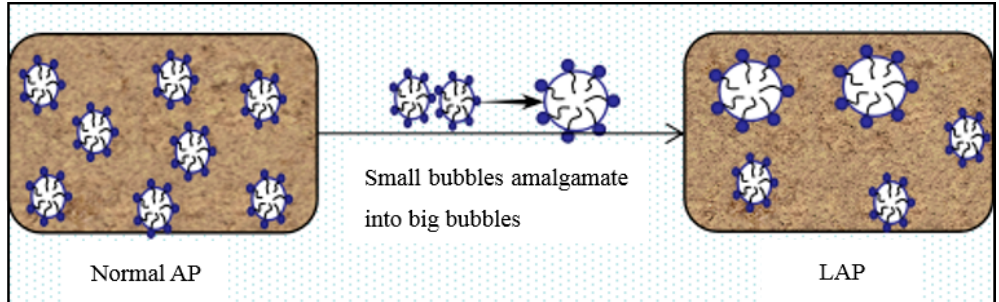
Figure 1. Schematic diagram of bubble amalgamation.